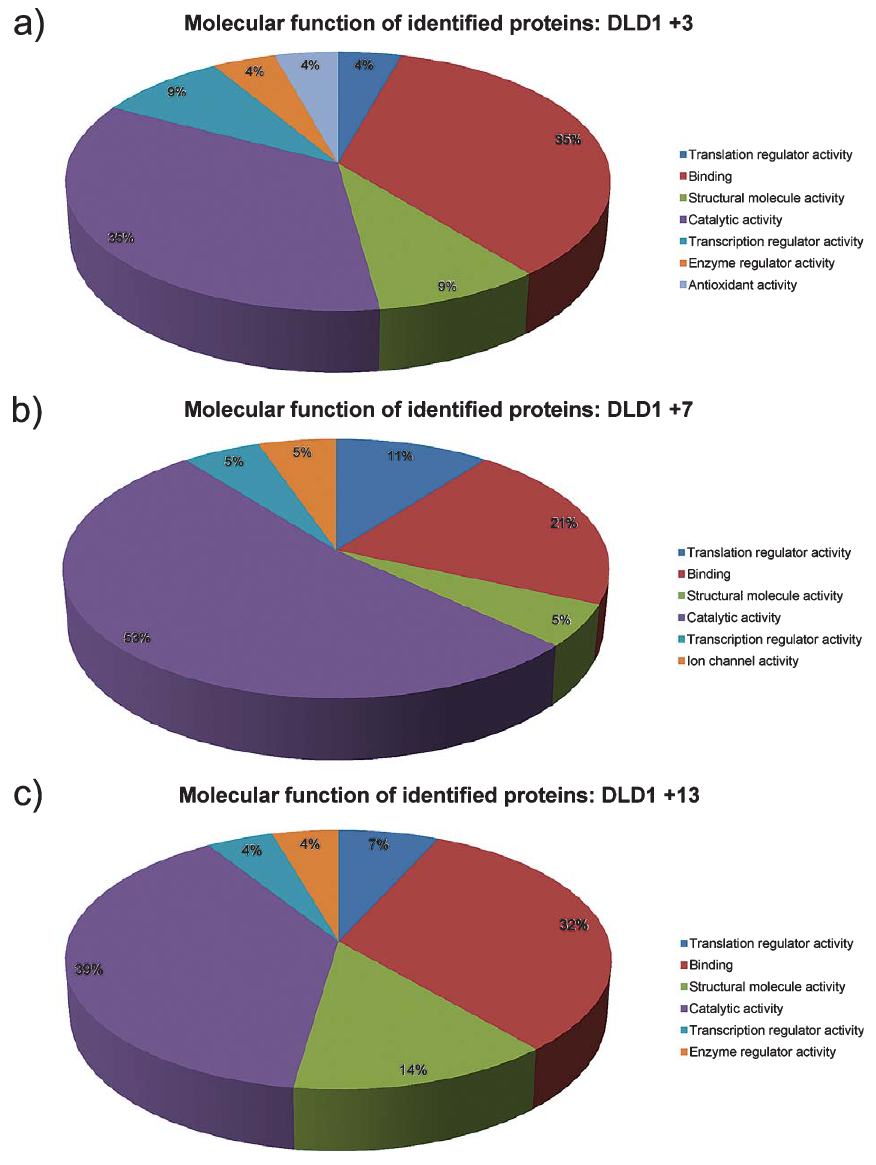
Fig. 3. Molecular functions of identified proteins in the DLD1+3 (a), DLD1+7 (b), DLD1+13 (c) comparisons based on the PANTHER classification